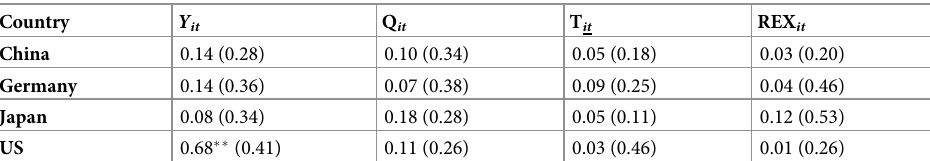
Table 12. PK msq test statistics.